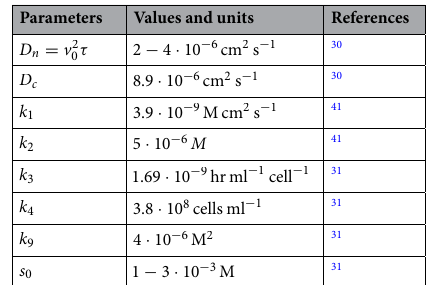
Parameters Values and